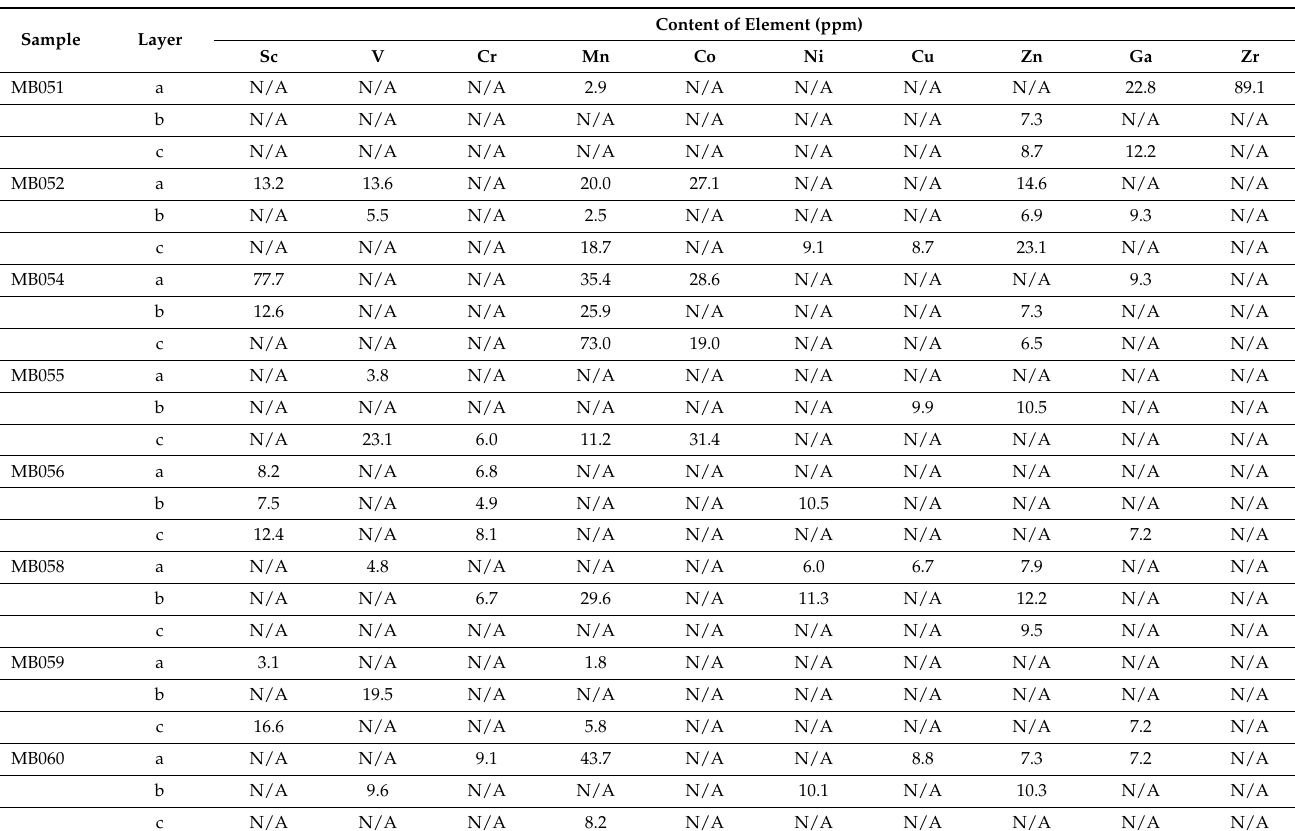
Table 3. Elemental composition of the burial potsherd samples collected from Ban Muang Bua probed by PIXE in (a) outer layer, (b) core, and (c) inner layer.